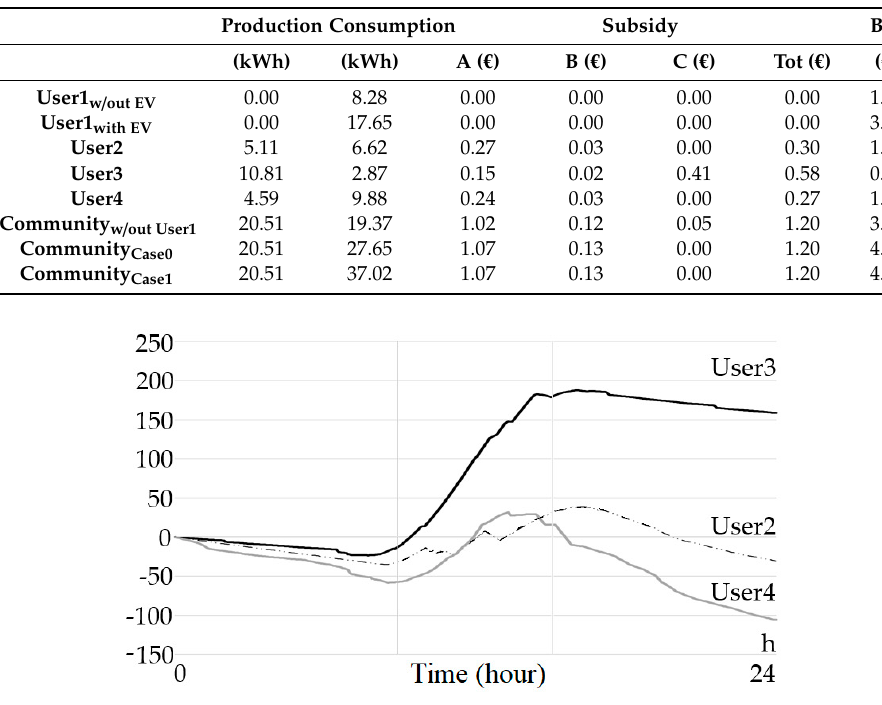
Figure 12. Algebraic sum of the values of users’ profiles over the day.